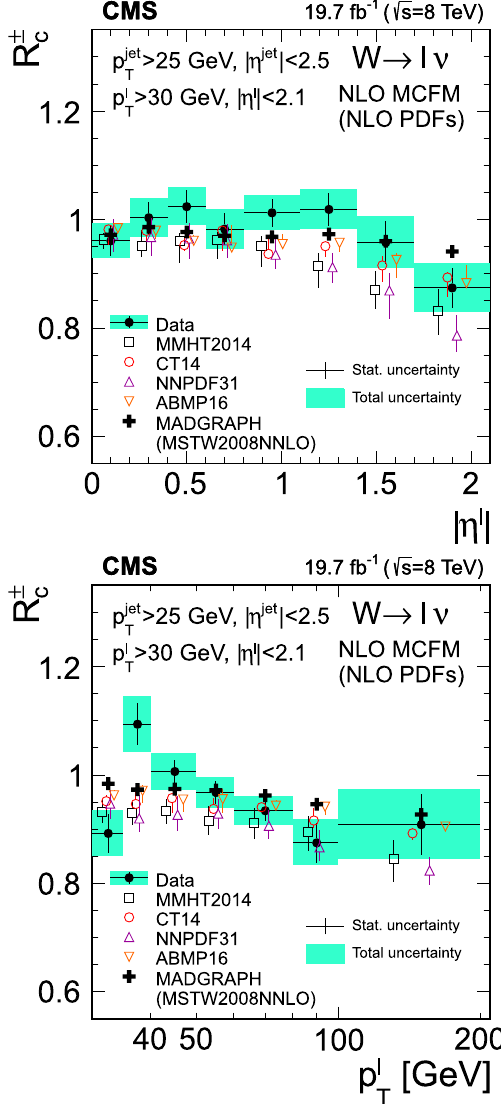
Fig. 5 Differentialcrosssections,d σ( W + c )/ d | η (cid:3) | (upper)andd σ( W + c )/ d p (cid:3) (lower). The data points are the combination of the results with Fig. 6 Cross section ratio, R ± c , as functions of | η (cid:3) | (upper) and p (cid:3) T the four different samples: SL and SV samples in W → e ν and W → (lower). The data points are the combination of the results from the μν events. Theoretical predictions at NLO computed with mcfm and SL and SV samples in W → e ν and W → μν events. Theoretical four different NLO PDF sets are also shown. Symbols showing the predictions at NLO computed with mcfm and four different NLO PDF theoretical expectations are slightly displaced in the horizontal axis for sets are also shown. Symbols showing the theoretical expectations are better visibility. The error bars in the mcfm predictions include PDF, slightly displaced in the horizontal axis for better visibility. The error α σ( W + c )/ d p (cid:3) , bars in the mcfm predictions include PDF, α S , and scale S , and scale uncertainties. The inset in the lower plot, d T zooms into the measurement-prediction comparison for the last bin, < 200GeV. Predictions from MadGraph using the PDF 100 < p (cid:3) T set MSTW2008NNLO are also presented